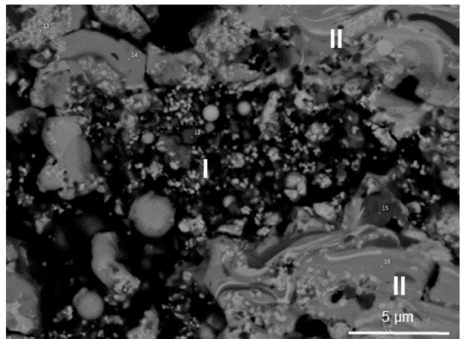
Figure 3. FE-SEM micrograph of Al 2 O 3 /TZ-3YS coating at 2500 × backscattering mode. Unmolten and molten zones are marked by I and II, respectively. Black and white particles inside the unmolten zone correspond to Al 2 O 3 and SiC,